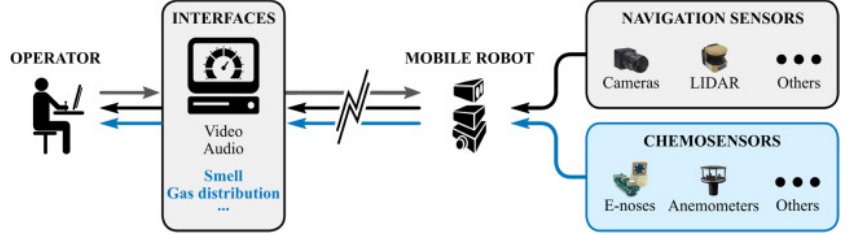
Figure 9. Diagram of a traditional teleoperation system (in black) and extended olfactory telerobotics (in blue). The latter requires equipping the mobile robot with additional sensors (e.g., an e-nose or an anemometer), and enhances the teleoperation user-interface to display this new sensory